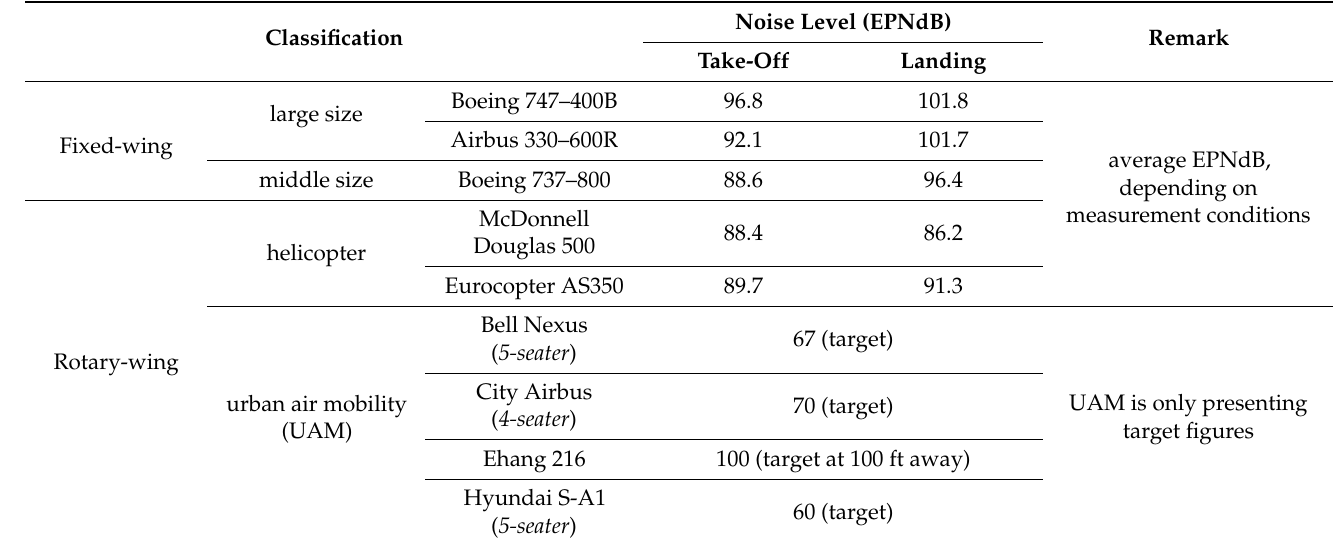
Table 3. Aircraft classification and noise levels (measured on